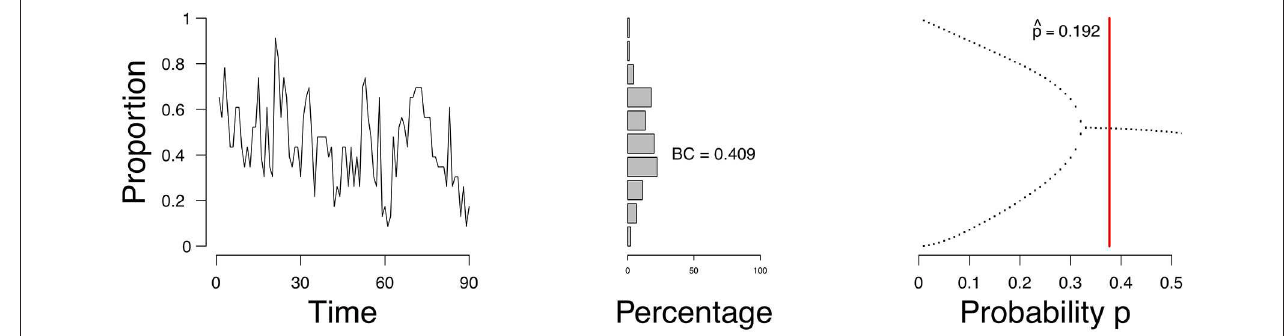
FIGURE 10 | Proportion of active symptoms (Left) and bifurcation diagram (Right) of one participant from the HowNutsAreTheDutch data. Red line indicates the estimate ˆ p .